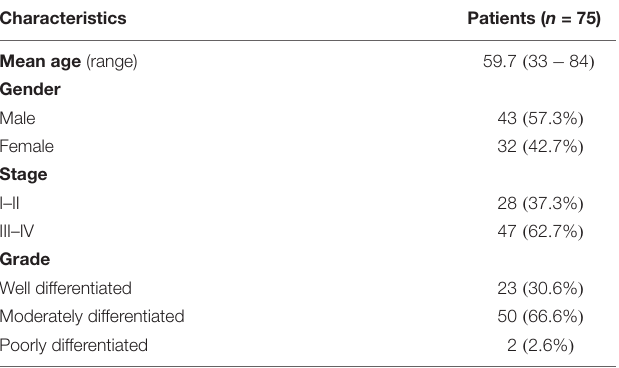
TABLE 1 | Characteristics of the patients included in the prognostic analysis.